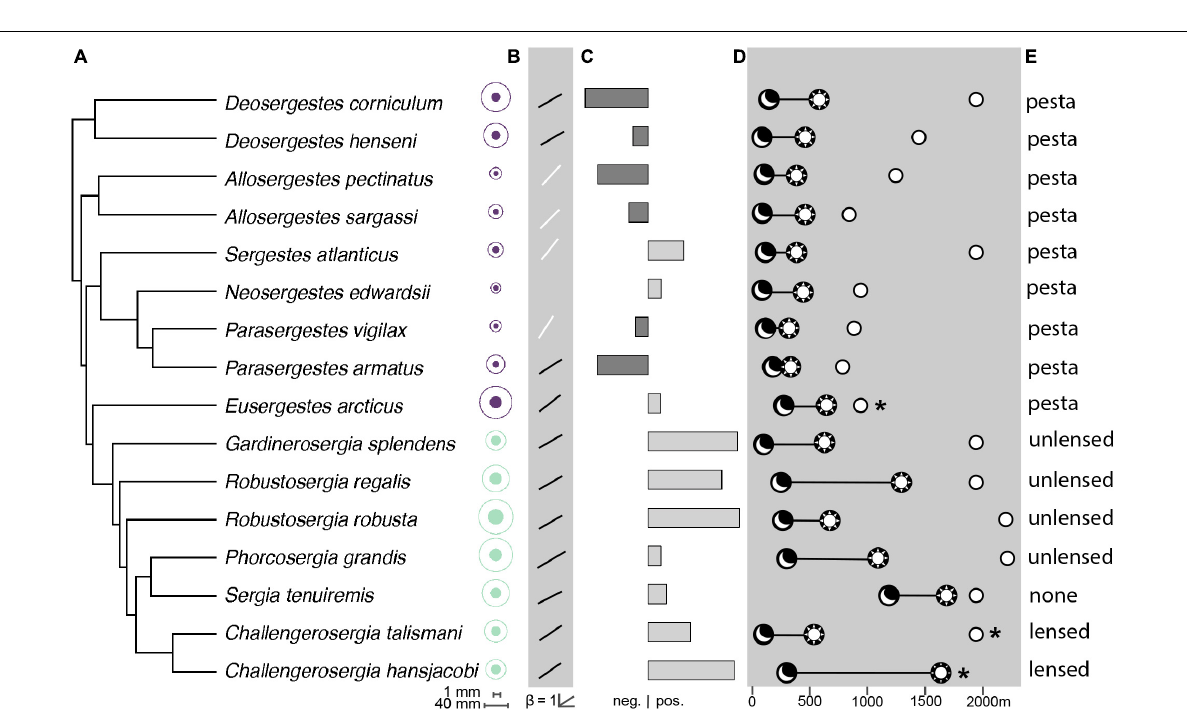
Frontiers in Ecology and Evolution |